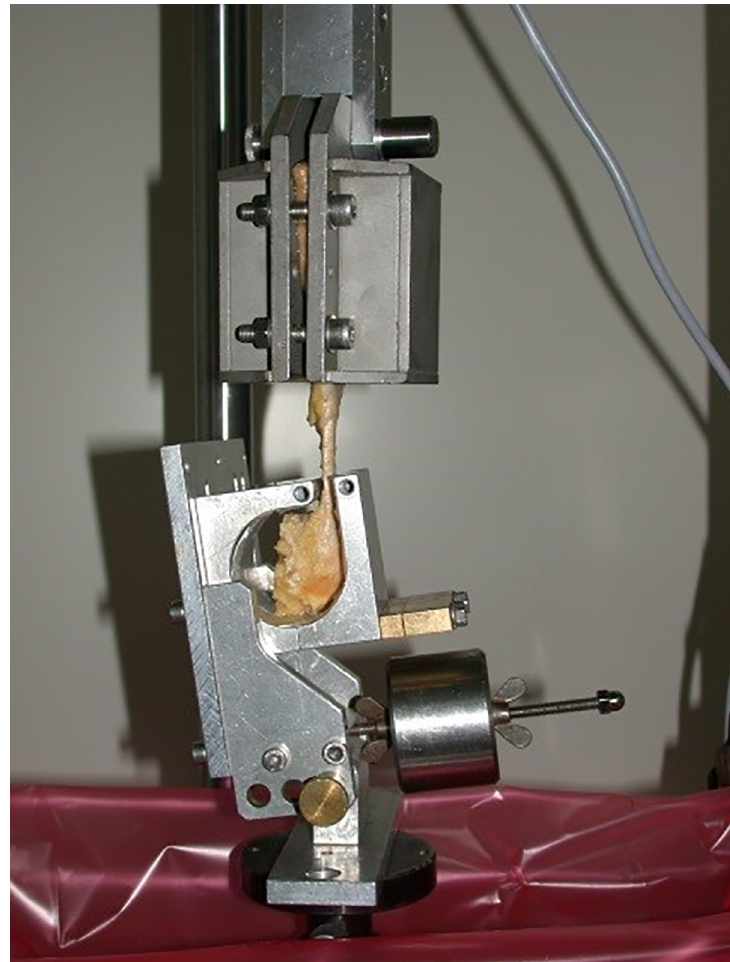
Fig 2. Setup of the Zwick testing machine. The muscle is clamped between metal brackets filled with dry ice. The calcaneus on the button will be cemented after proper